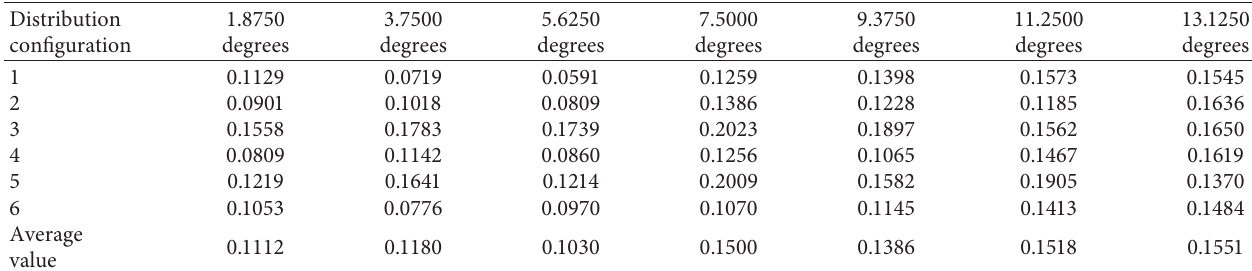
Table 4: Comparison of absolute